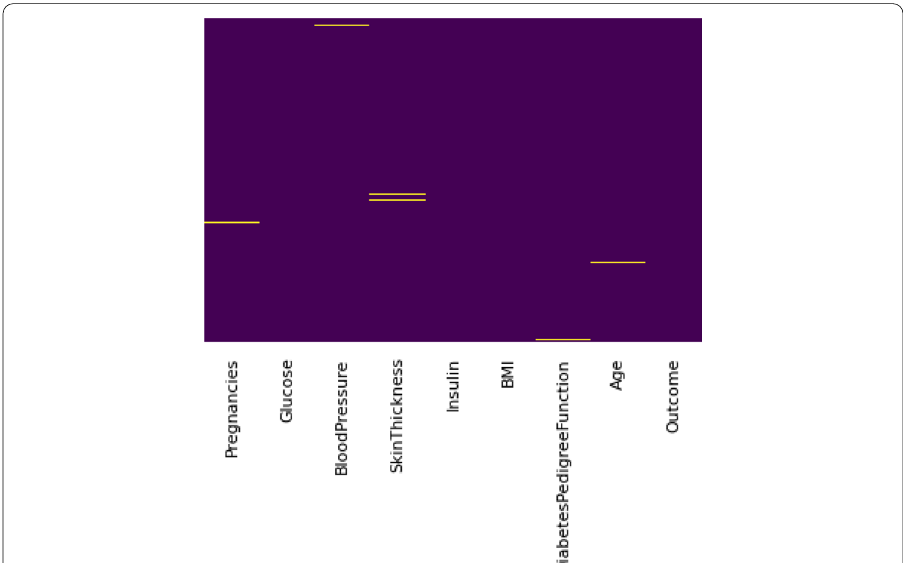
Fig. 4 Before cleaning: checking missing values. In purple: non-missed value. Yellow: missed